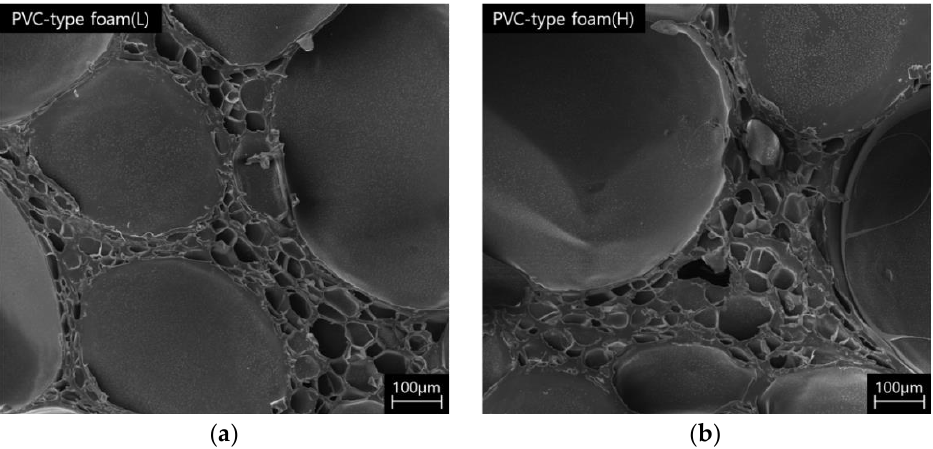
Figure 5. Micrograph of a PVC-type foam with a wide distribution of cell sizes: ( a ) PVC-type foam (L) and ( b ) PVC-type foam (H).